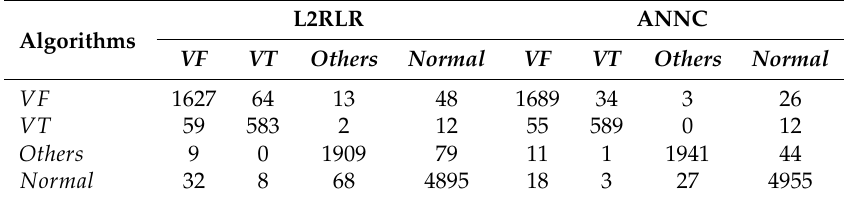
Table 3. Confusion matrix for classification of VF , VT , Others , and Normal using the L 2 RLR and ANNC algorithms.